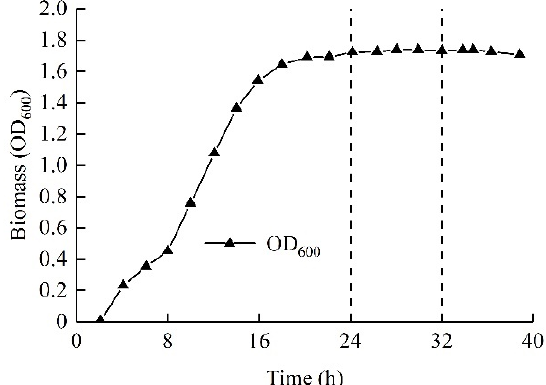
Figure 3. The growth curve of Bacillus pasteurii .